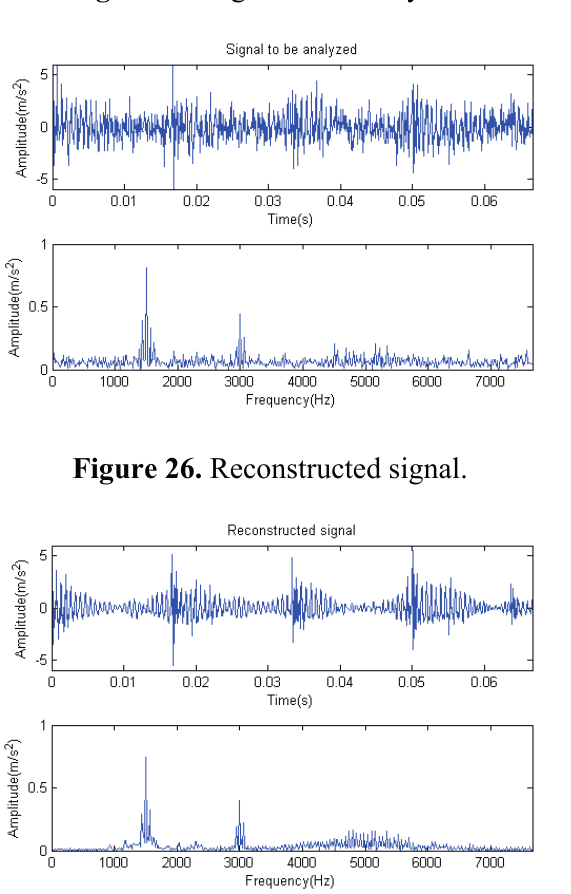
Figure 25. Signal to be analyzed.